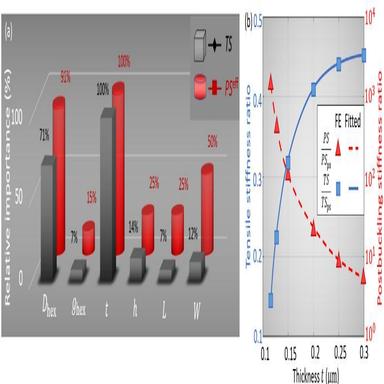
(a) Sensitivity analysis on the influences of the predicting variables on TS and PSeff for the corrugated metastructures designed by the EC prediction models. (b) Comparisons of the tensile and effective postbuckling compressive stiffnesses between the corrugated metastructures designed by the EC models and uncorrugated planar sheets that have the same length L = 4 mm and width W = 2 mm, and the thickness t is varied from 0.1 − 0.3 μm (The corrugation pattern in the metastructures are: h = 25 μm, Dhex = 120